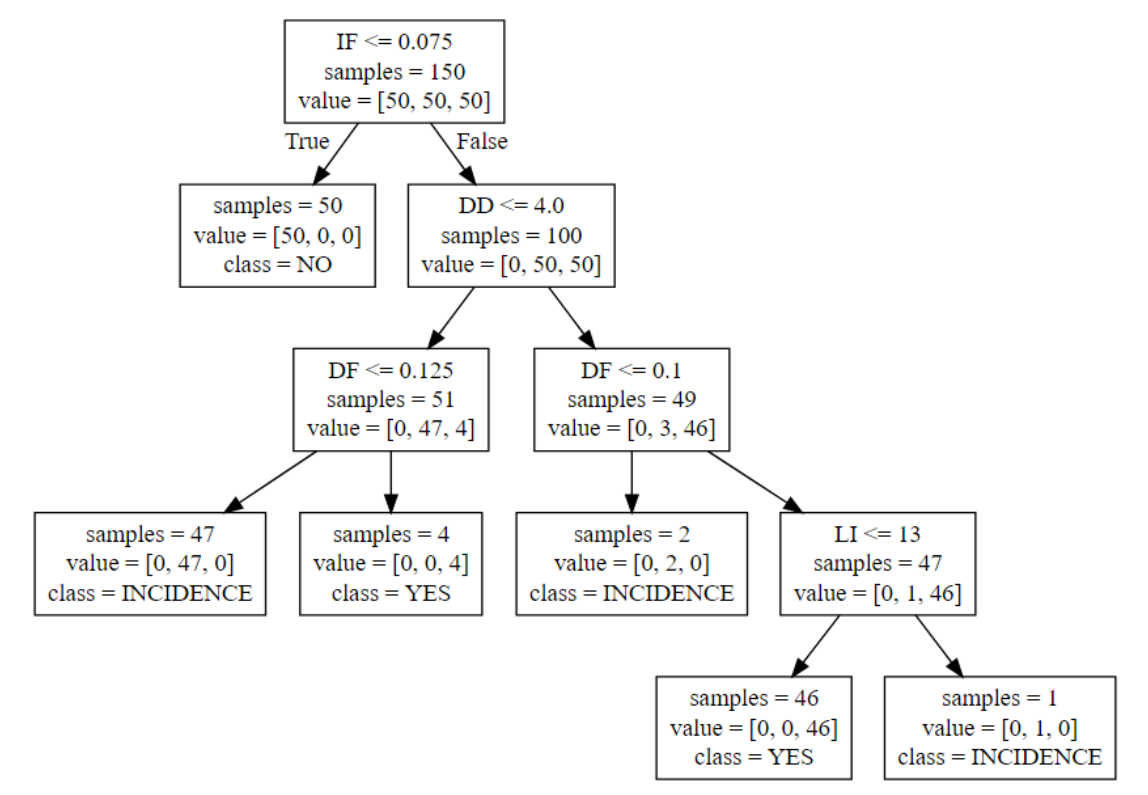
Figure 6. Sample decision tree